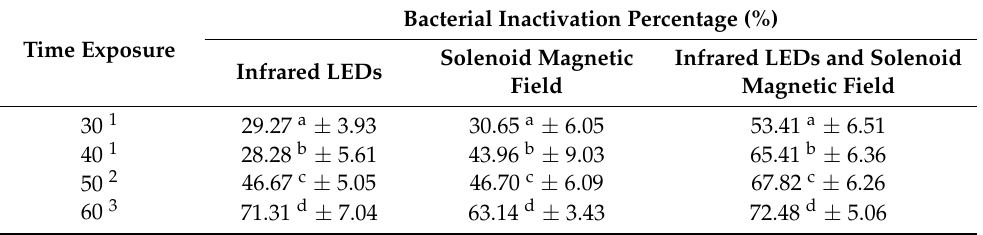
Table 5. Table of conclusions on statistical test results on Escherichia coli bacteria.